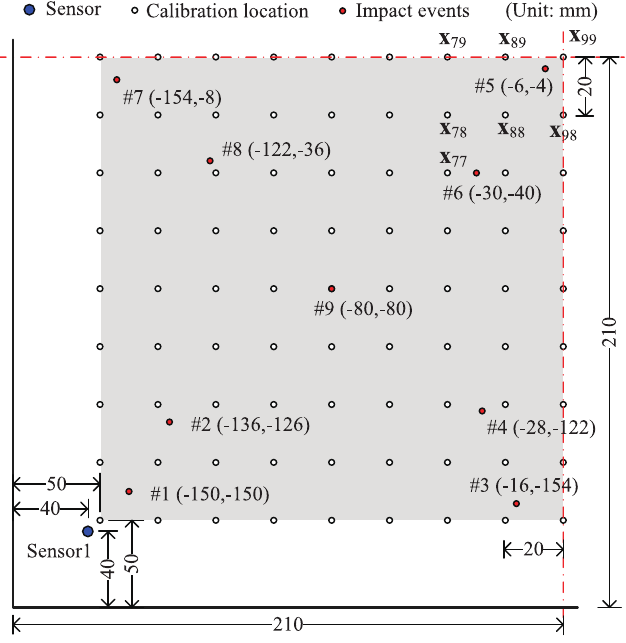
Fig. 2. Sensor, impact location and calibration locations with 20 mm